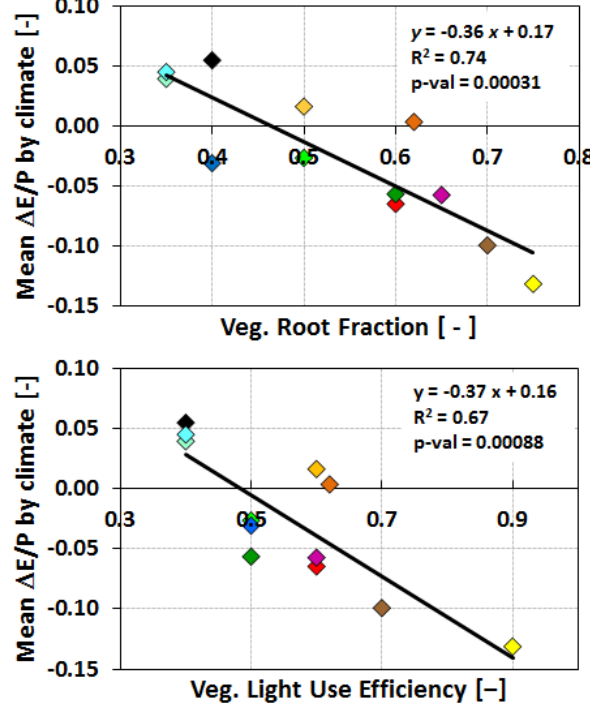
Fig. 7. Correlations between mean 1E/P by climate and maxi- mum value of the averaged leaf area index curve (sample size: 12; p value: 0.005).